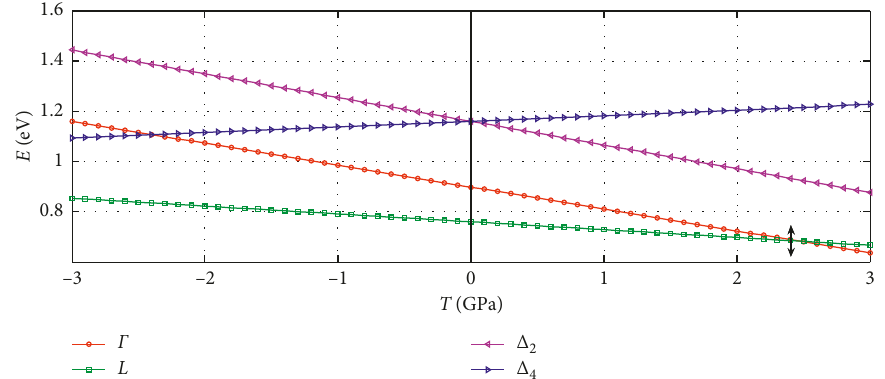
Figure 2: The variation of the energy levels of Ge conduction with the (001) biaxial tensile stress.